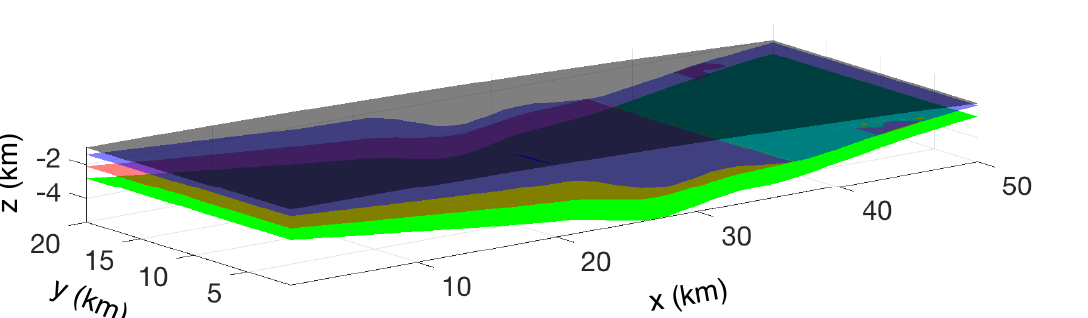
Figure 6. Kriging-based basin-scale reconstruction of layers